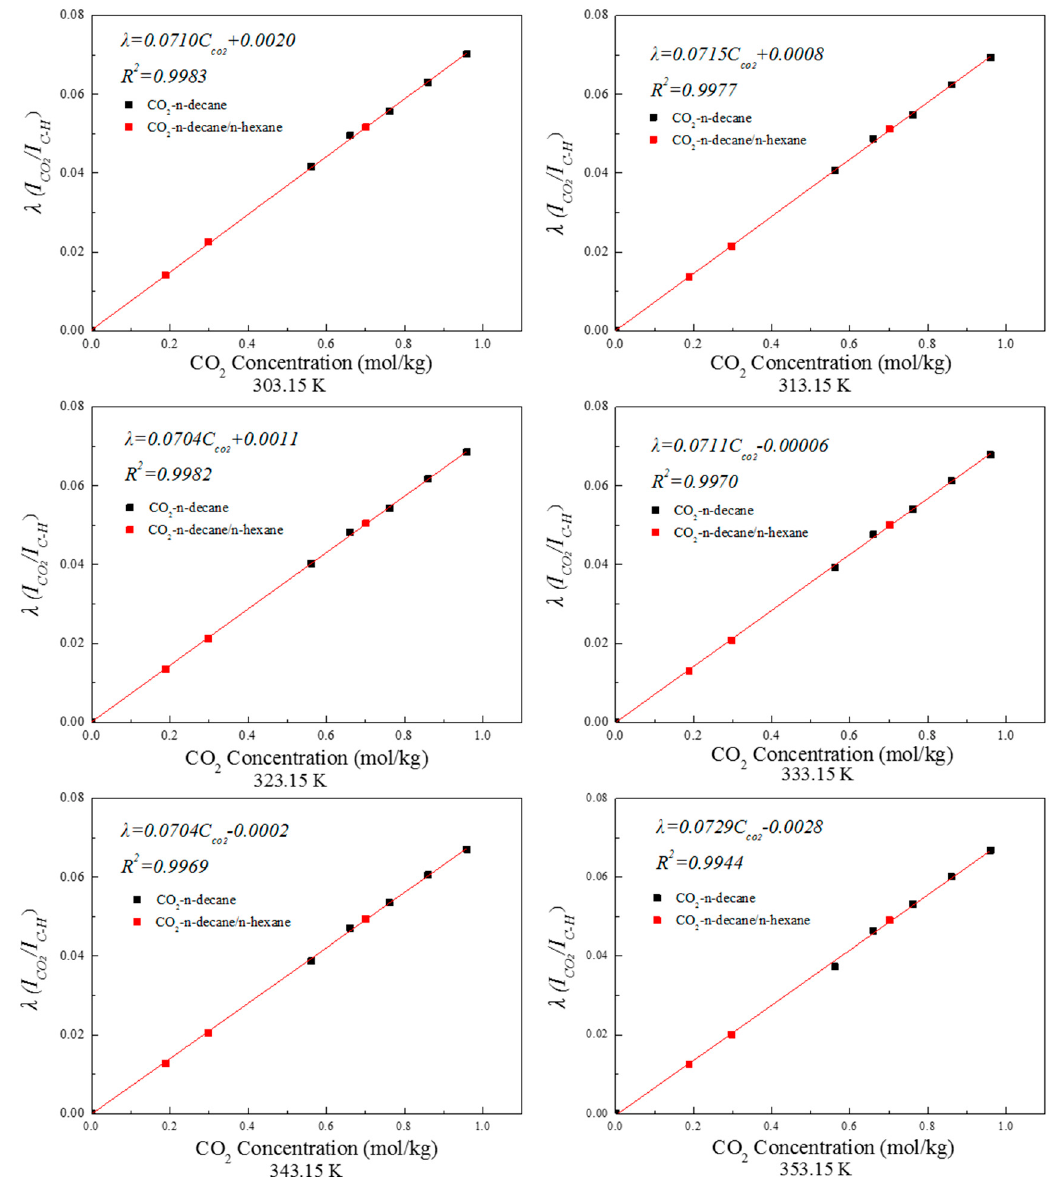
Figure 4. Verifying the relationship between CO 2 concentration and the Raman peak intensity ratio of CO 2 + n − decane + n − hexane at di ff erent temperatures .